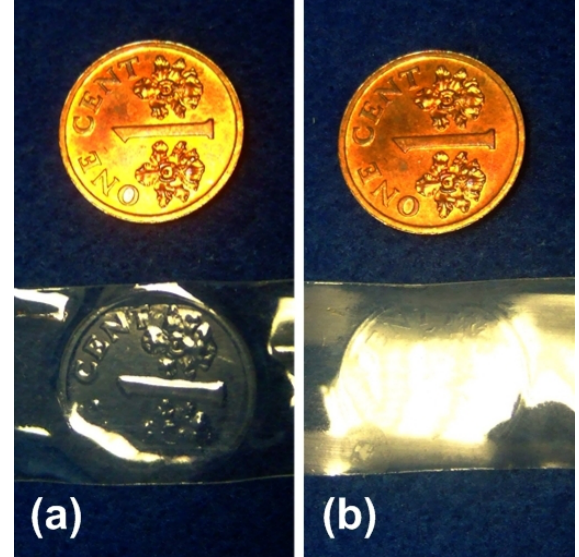
Figure 25. Polymeric anti-counterfeit label. ( a ) Before heating; and ( b ) after heating using a